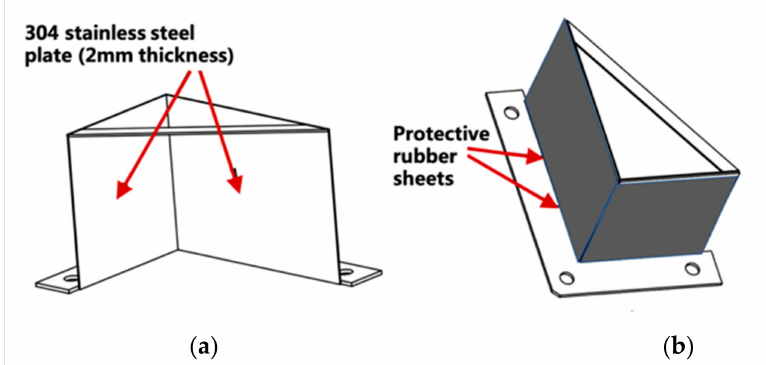
Figure 2. Protective cover for the sensors: ( a ) stainless steel plate of the cover, ( b ) protective rubber sheets on the outer cover surface.